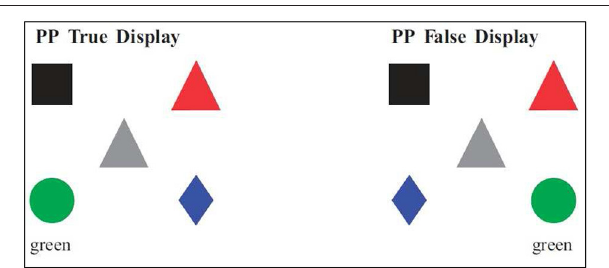
FIGURE 12 | Picture from experiment 1 by Schwarz (2016).